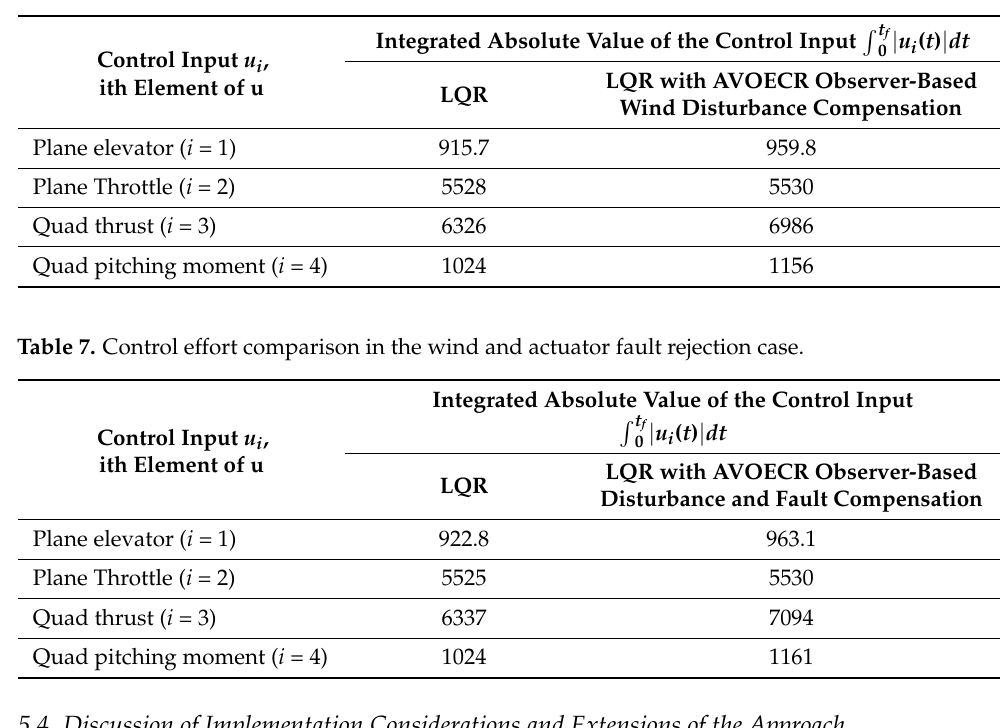
Table 6. Control effort comparison in the wind disturbance rejection case.